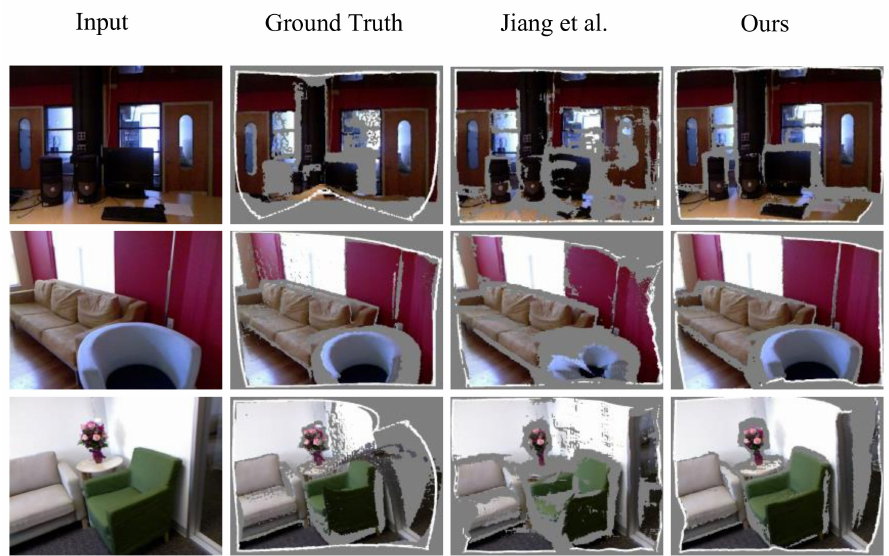
Figure 11. 3D visualization results on the NYU v2 dataset. The first column to last column: input, ground truth, depths recovered by Jiang et al. [48] and our method.